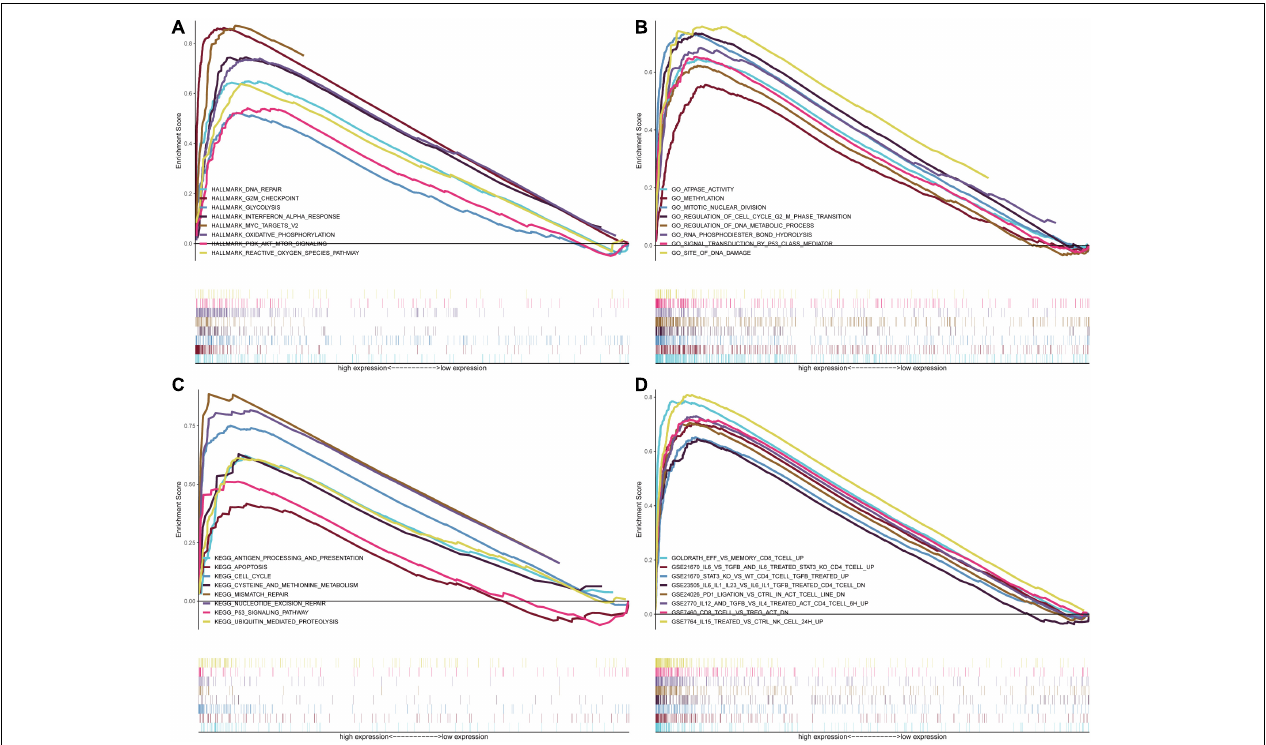
FIGURE 6 | GSEA for samples with high risk and low risk based on the prognostic index of the three-gene signature. (A) The enriched gene sets in GO collection by the high-risk sample. Each line representing one particular gene set with a unique color, and the upregulated genes located in the left approaching the origin of the coordinates, by contrast the downregulated lay on the right of the x -axis. Only gene sets with NOM p < 0.05 and FDR q < 0.05 were considered significant, and only several leading gene sets were displayed in the plot. (B) The enriched gene sets in KEGG by samples with the high-risk sample, and only several leading gene sets were displayed in the plot. (C) Enriched gene sets in HALLMARK collection by samples of the high-risk sample. Only several leading gene sets are shown in the plot. (D) Enriched gene sets in C7 collection, the immunologic gene sets, by samples of the high-risk sample. Only several leading gene sets are shown in the